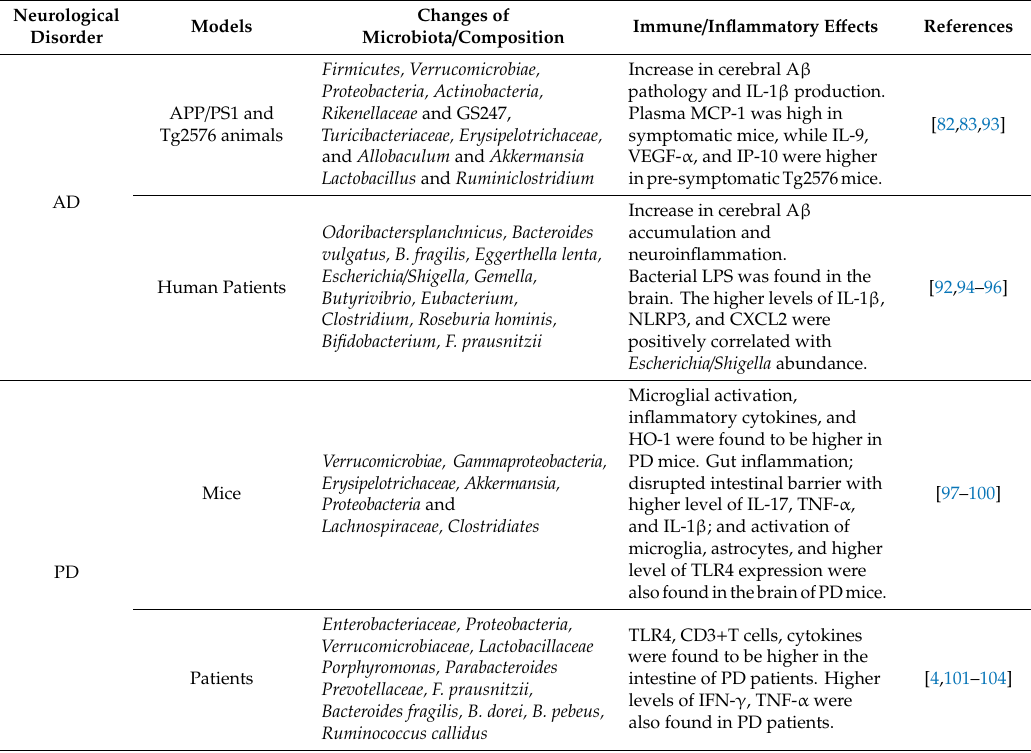
Table 1. Alternation of gut microbiota and related immune / inflammatory e ff ects in animal and patients with neurological